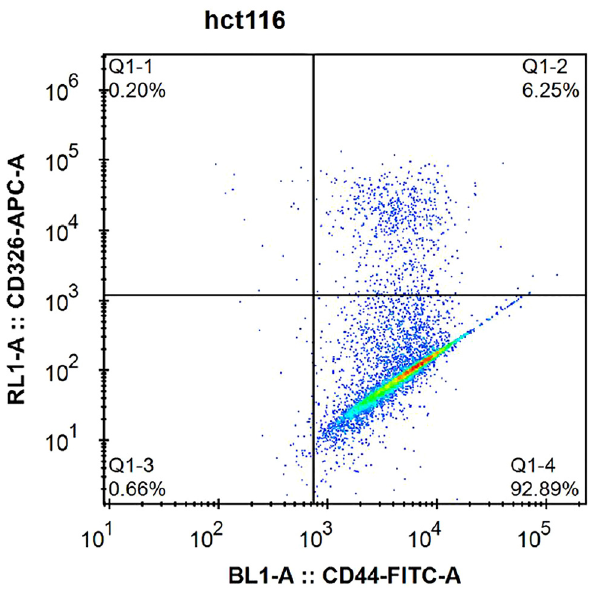
Figure 1: The proportion of the EpCAM high /CD44 + subset in the human colorectal cancer cell line HCT116.